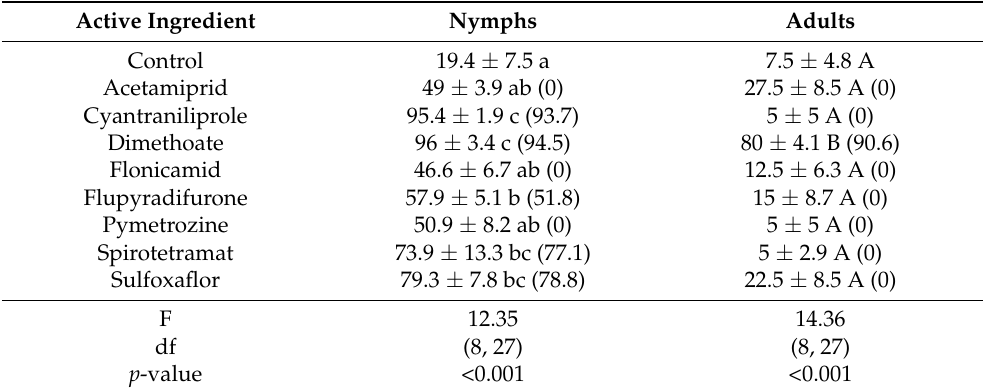
Table 3. Mean percentage of T. erytreae nymph mortality (%) ± standard error in systemic bioassays. In brackets the mean percentages of corrected mortality (%). The mortality was recorded 48 h after shoots were